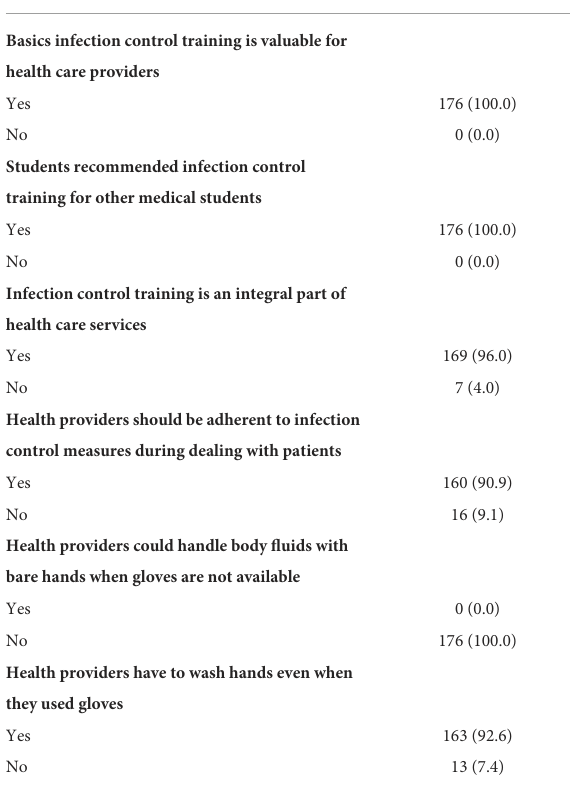
TABLE 5 Students’ attitude toward basics of infection control after